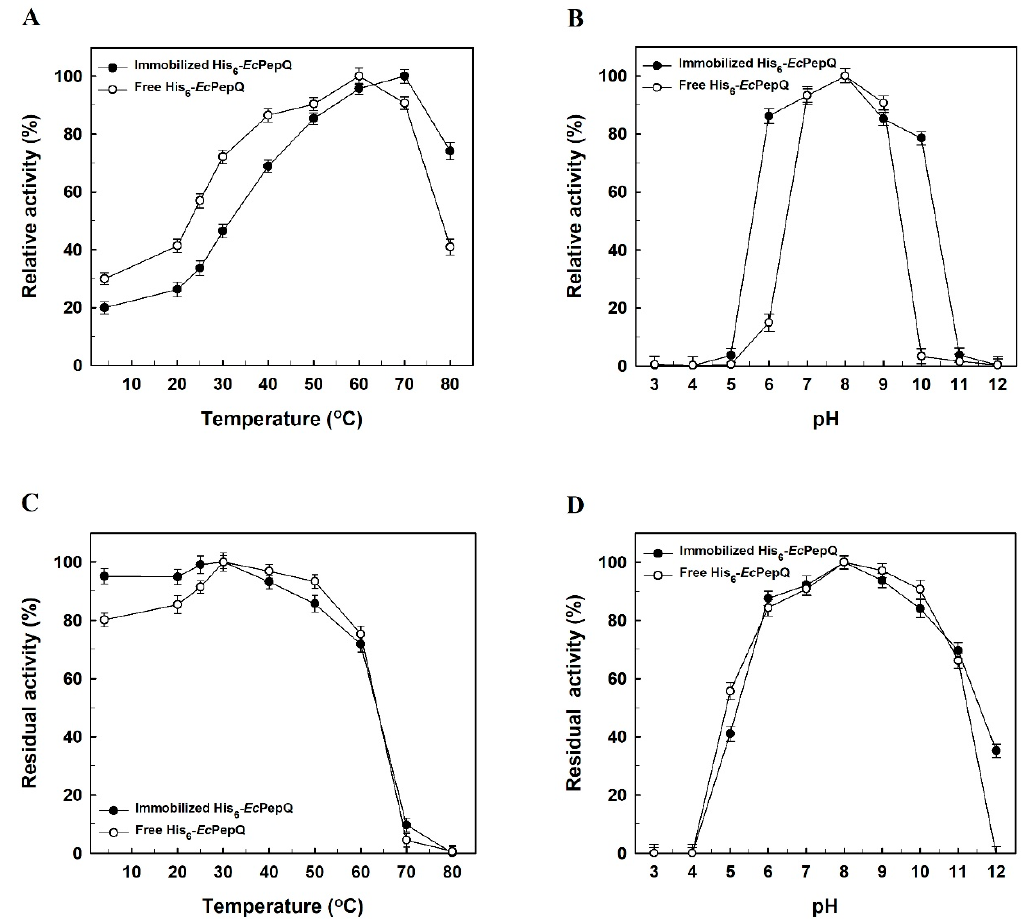
Figure 5. Effects of temperature and pH on the activity ( A , B ) and stability ( C , D ) of free and immobilized enzymes. The data are the average of three independent experiments with standard deviations.